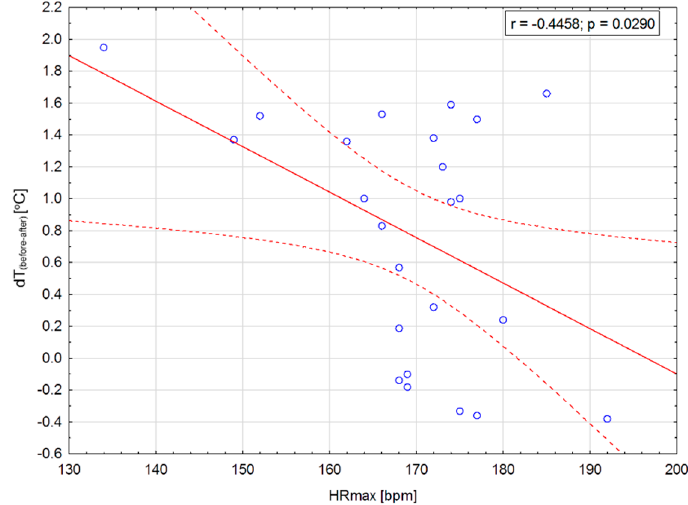
Figure 8. Correlation between the body surface temperature coefficient dT (defined as body temperature before-body temperature after training) and maximum heart rate obtained for all measured subjects.